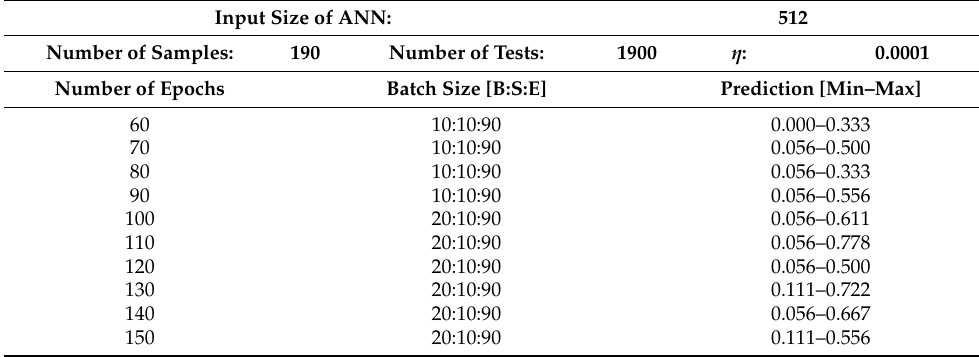
Table 8. Effectiveness of signal classification using CNN based on the PRI